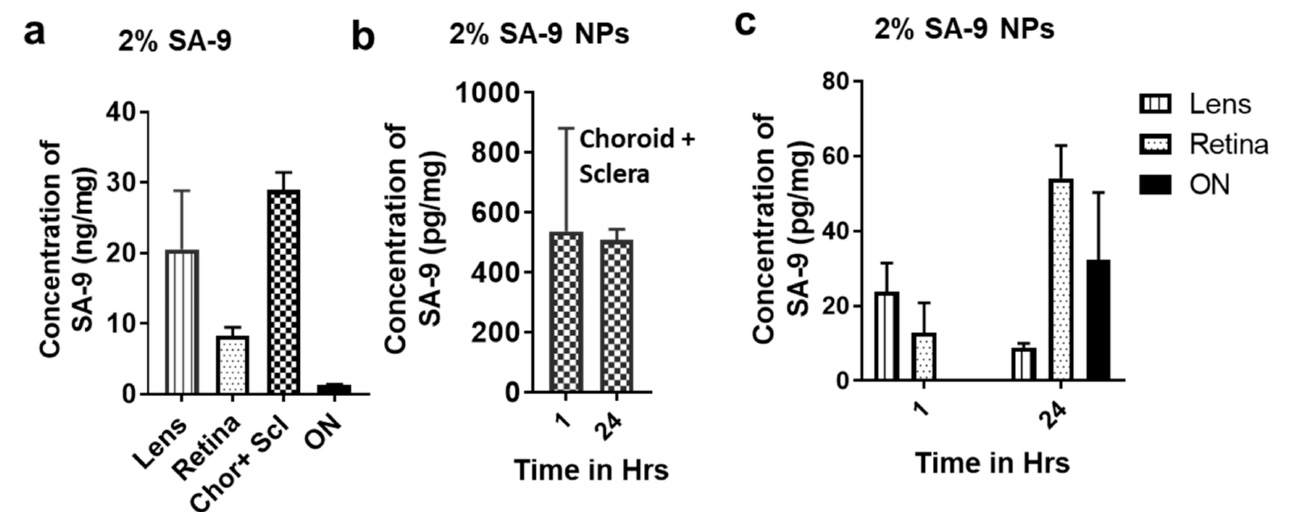
Figure 8. ( a ) Concentration of SA-9 in lens, retina, choroid + sclera, and optic nerves (ON) after 1 h of single eyedrop administration of 2% SA-9 in PBS to mice eyes. ( b ) Concentration of SA-9 after 1 h and 24 h time-points in combined choroid and sclera tissues after single eye drop administration of 2% SA-9 NPs nanosuspension in PBS to mice eyes. ( c ) Concentration of SA-9 in lens, retina, and ON at 1 and 24 h after single eye drop administration of 2% SA-9 NPs nanosuspension in PBS to mice eyes. No SA-9 was detected after 1 h in ON. Blank nanoparticle was dosed to control mice and no drug was detected there. N = 12